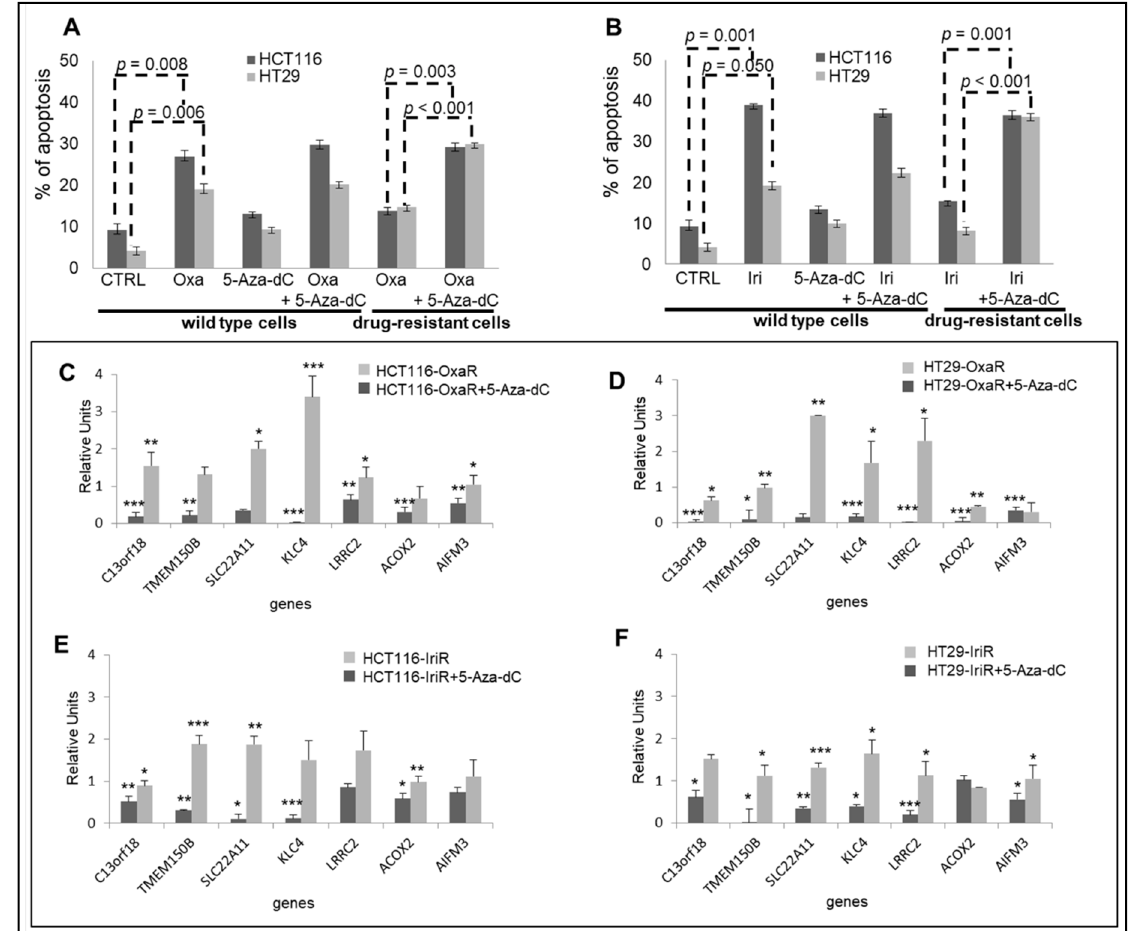
Figure 6. Validation of the eight-gene signature in drug-resistant CRC cell lines. ( A , B ). Apoptotic cell death in HCT116 and HT29 drug-sensitive and drug-resistant CRC cell lines exposed to 10 uM 5-Azacytidine (5-Aza-dC) for 48 h and/or 3 uM oxaliplatin (Oxa) ( A ) or 2uM irinotecan (Iri) ( B ) for 24 h. ( C – F ). Real-time differential expression analysis of eight genes belonging to the prognostic signature between drug-resistant and drug-sensitive CRC cell lines before and after exposure to 10 uM 5-Aza-dC for 48 h. C. HCT116-OxaR: D. HT29-OxaR; E. HCT115-IriR; F, HT29-IriR. Significantly modulated genes are indicated by asterisks: * = p < 0.05; ** = p < 0.01; *** = p < 0.001. Apoptosis and PCR analyses were performed in triplicate .